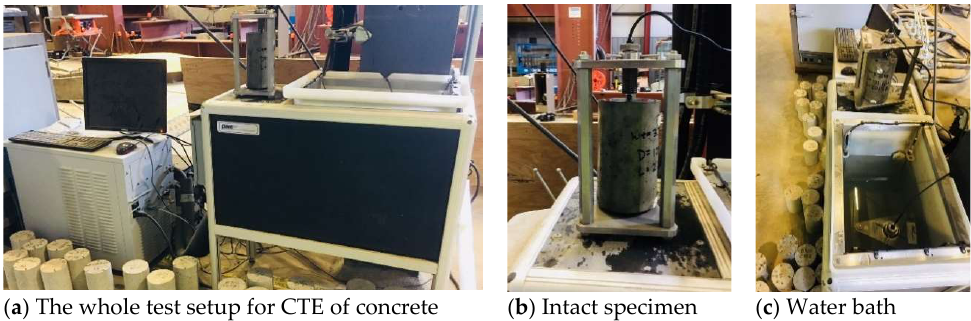
Figure 3. Test setup for the determination of the coefficient of thermal expansion (CTE) of the cylindrical concrete specimens.